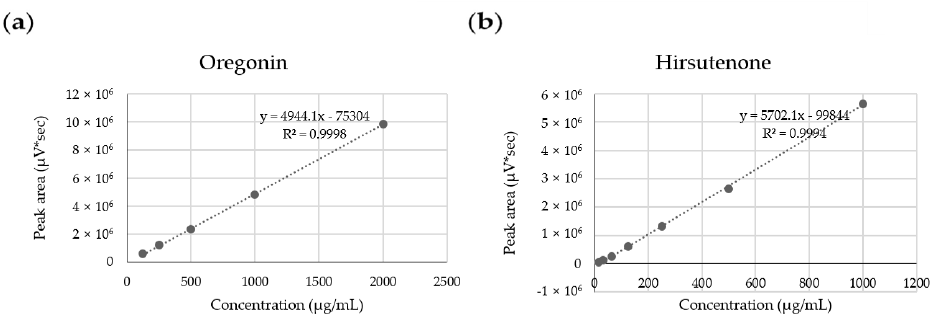
Figure 2. Linearity and correlation coe ffi cients of e ff ective (indicator) components (R 2 ). ( a ) Oregonin; ( b ) hirsutenone.